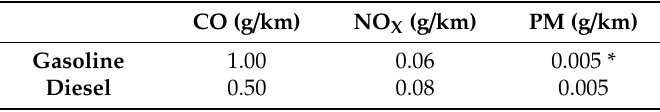
Table 6. Overview of EURO 6 emission limits